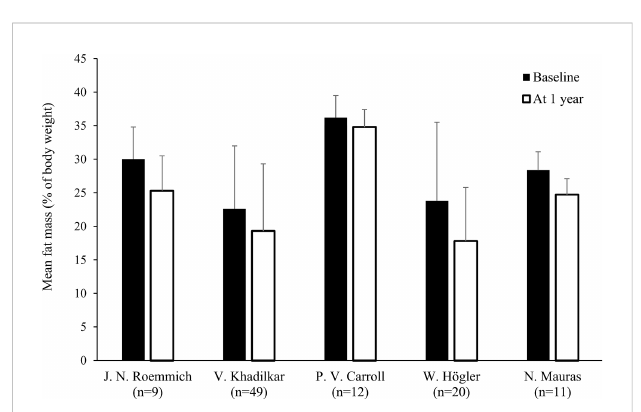
FIGURE 3 Fat mass (mean % of body weight with standard deviation) at baseline and after 1 year a of rhGH replacement in pre-pubertal patients b with GHD (18, 22, 24, 27, 28). a Two months of replacement in Mauras et al. b Carroll et al. enrolled a post-pubertal population. GHD, growth hormone de fi ciency; rhGH, recombinant human growth hormone.